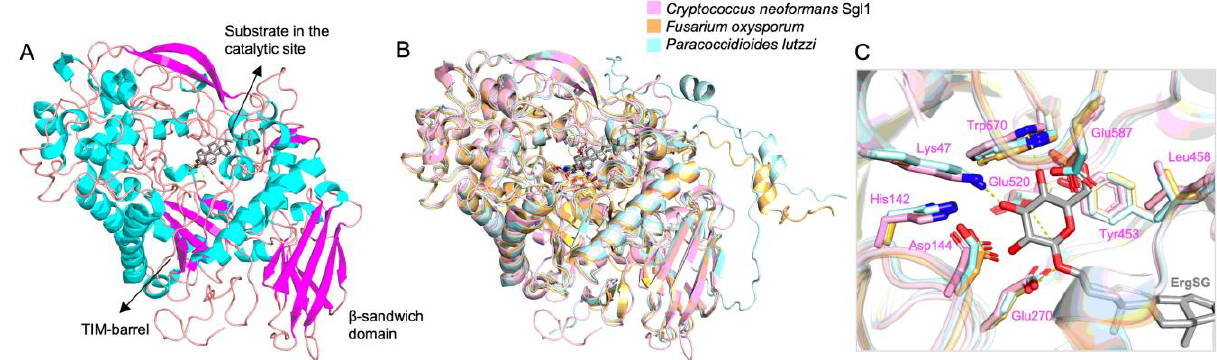
Figure 2. SGL1 homologs structural comparison. ( A ) Cryptococcus neoformans Sgl1 structure (PDB: 7LPO) with ergosterol 3 β -D-glucoside (gray) docked in the active site. ( B ) Fusarium oxysporum (orange) and Paracoccidioides lutzii (cyan) Alphafold models superposed on Sgl1 (pink) structure. ( C ) The residues on the glucose binding site are conserved in a similar position in F. oxysporum and P. lutzzi models. Sgl1 residues are shown in pink.